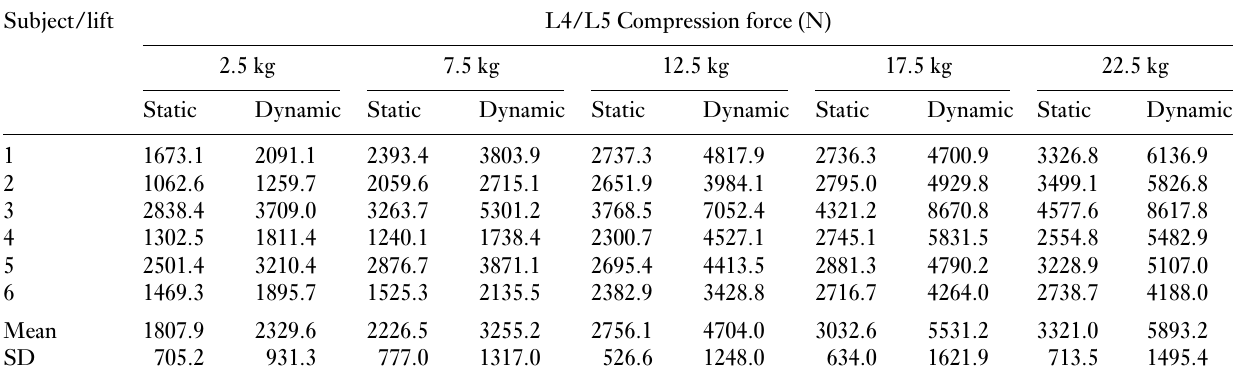
Table 2 The compression forces calculated by 4D WATBAK and the inverse dynamics model for the six subjects during the five